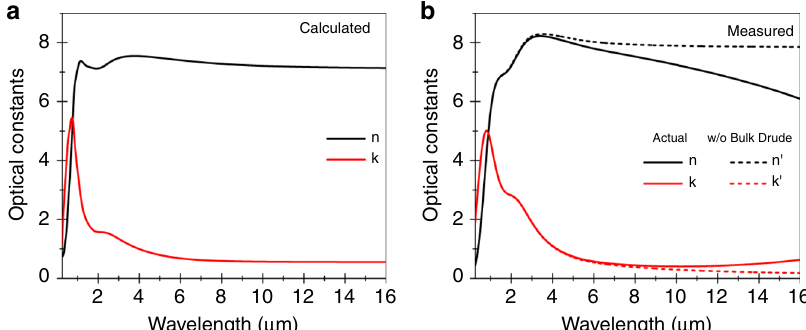
Fig. 2 Infrared refractive index of Bi 2 Te 3 topological insulator crystals. Dispersion of the complex refractive index a calculated from fi rst-principles technique and, b measured experimentally (solid lines) from ellipsometry and infrared spectroscopy measurements. The dashed lines correspond to the case in which the Drude contribution from bulk free carriers is